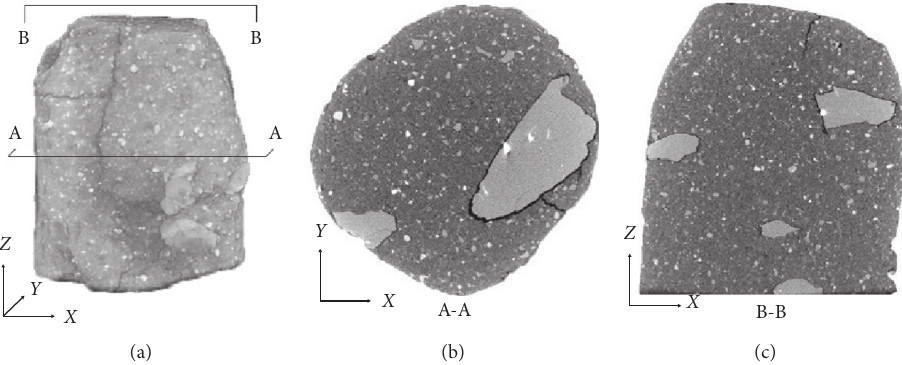
Figure 3: Images of the compacted GMZ bentonite: (a) 3D volume image; (b) 2D section in the X - Y plane; (c) 2D section in the X - Z plane.